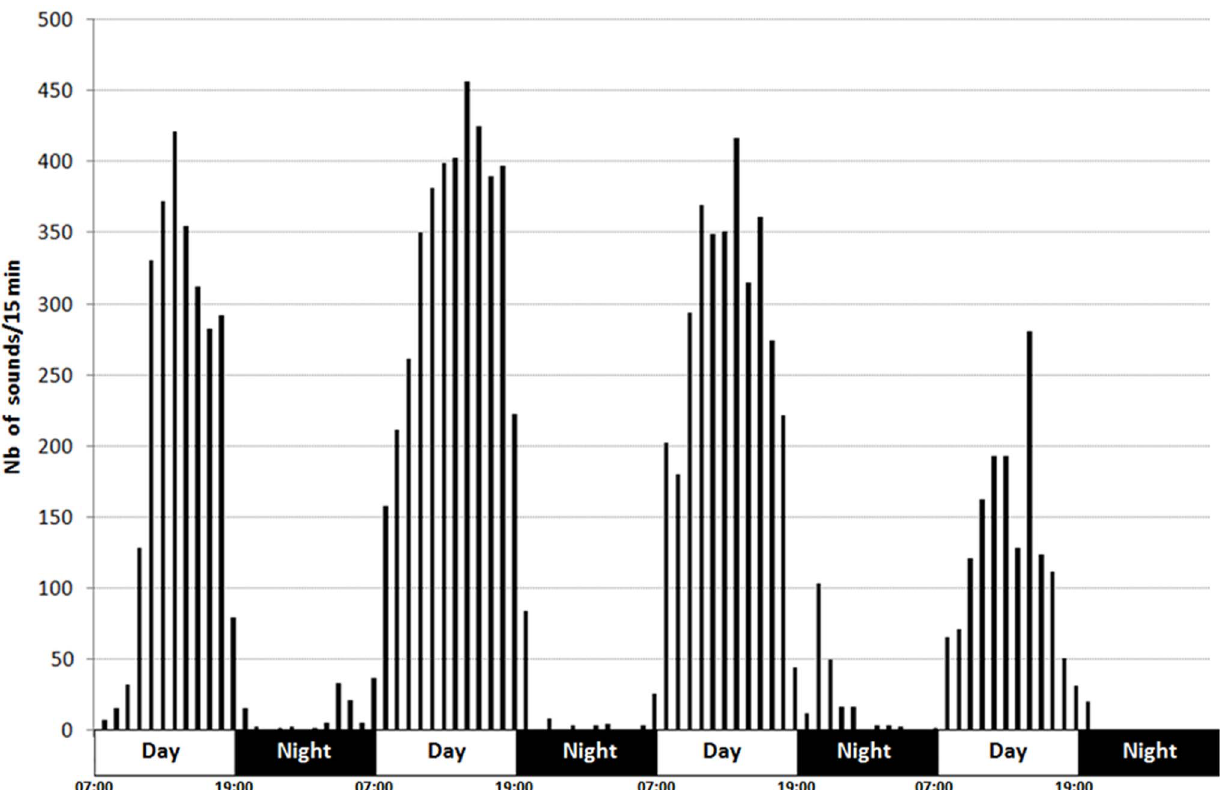
Figure 2. Diurnal production of sounds in Oreochromisniloticus , mean ± SD (n=8 days, N=25 fishes including 15 = and 10 R ).